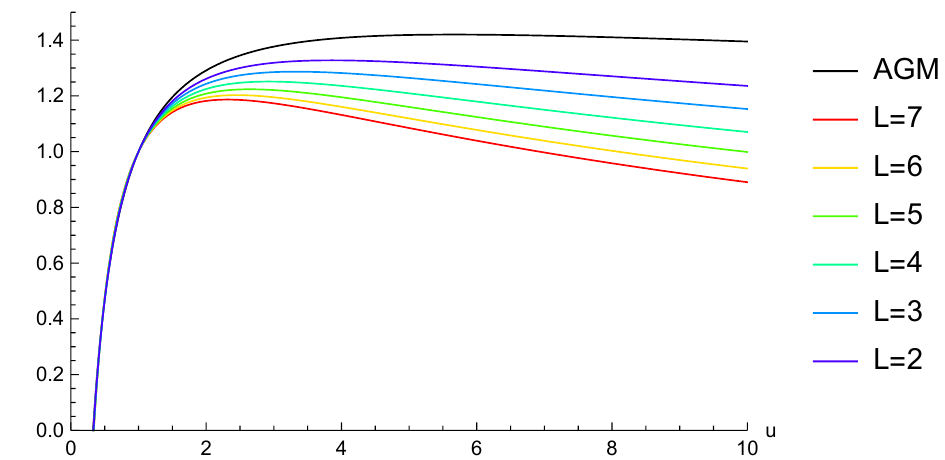
Figure 8 . Normalized perturbative coe(cid:14)cients of the remainder function, R ( L ) for L = 2 to 7, plotted along with the strong-coupling result of AGM. The curves all have a remarkably similar shape for u .